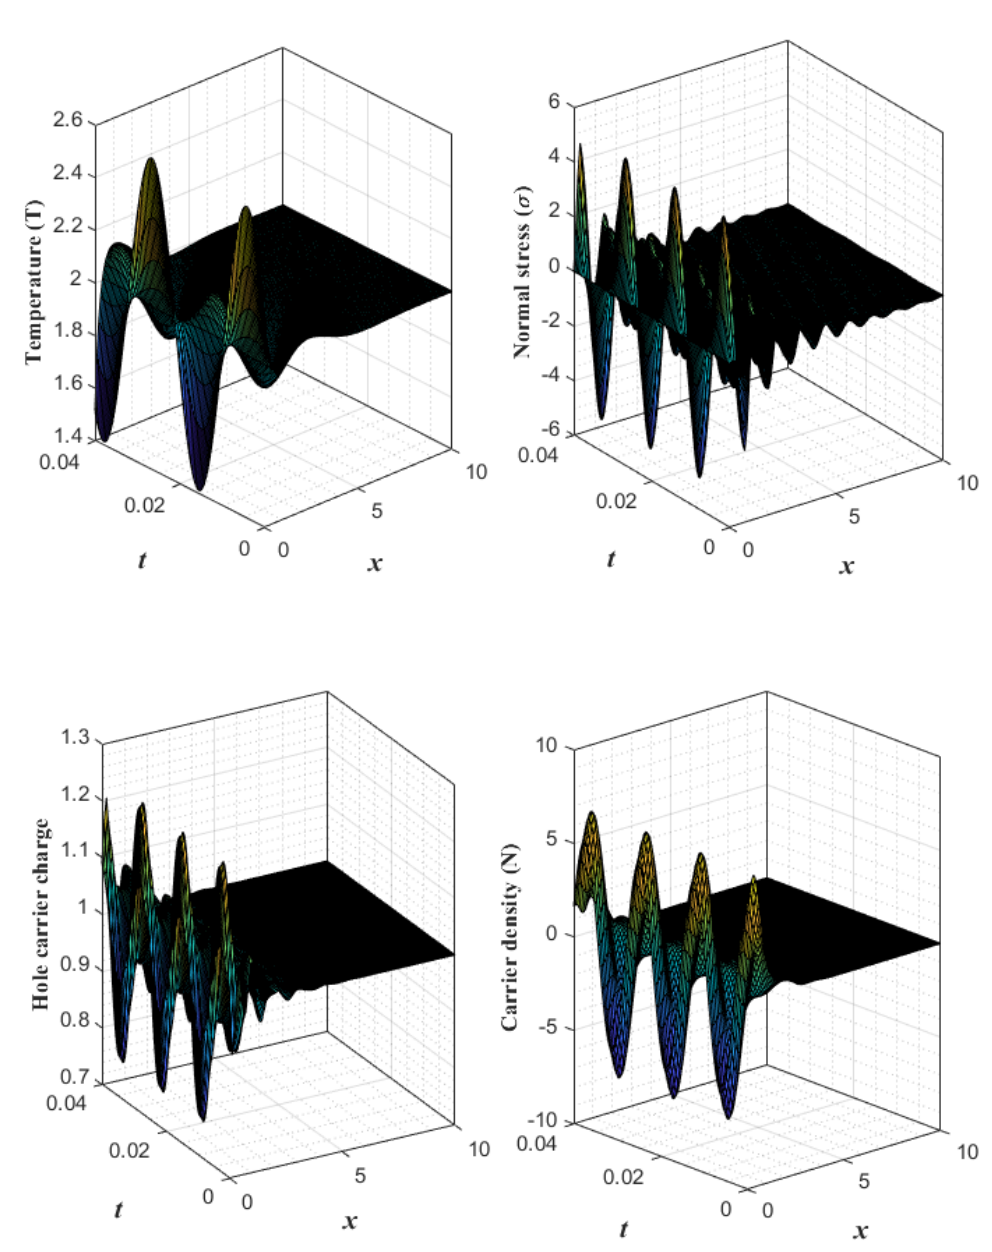
Figure 6. The effect of laser pulses and Hall current on the spatial and temporal distributions of the principal fields in three dimensions, as predicted by the DPL model.